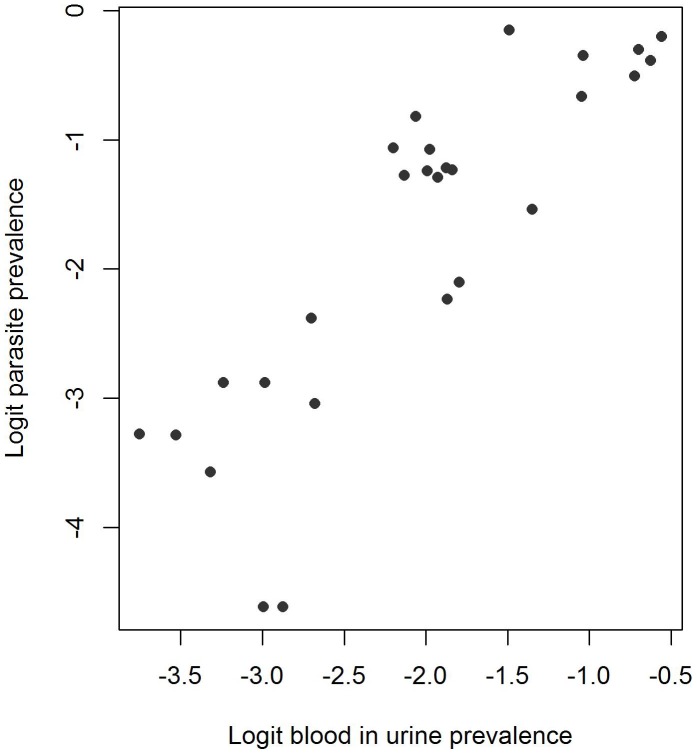
Relationship between the prevalence of reported blood in urine and prevalence of S. haematobium.Data are displayed following an empirical logit transformation.